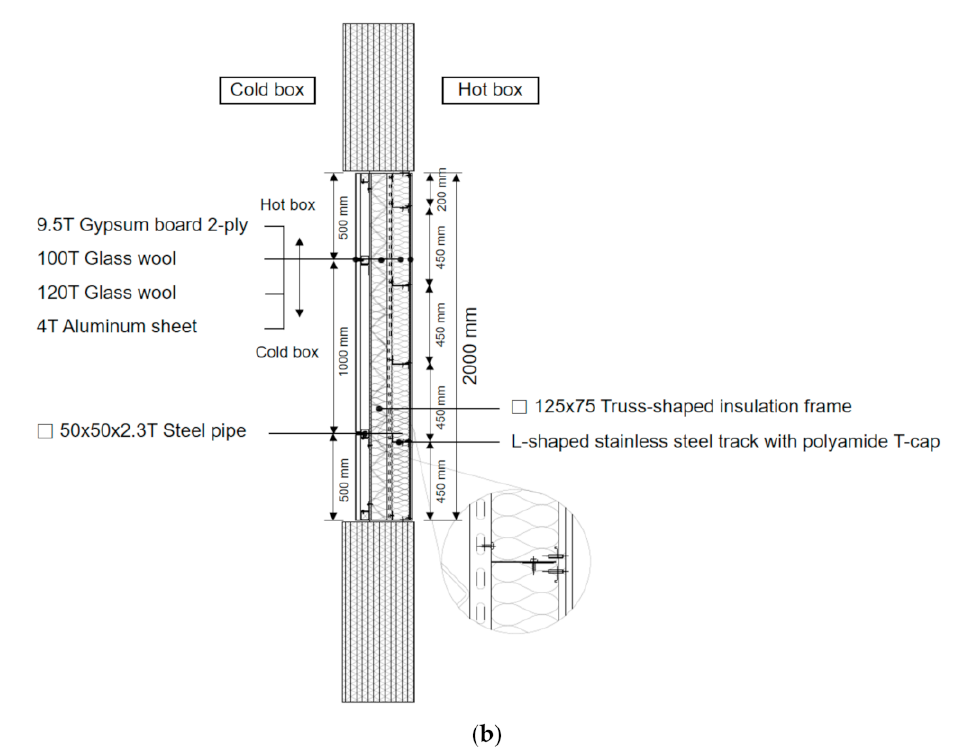
Figure 12. Vertical sections of mock-ups: ( a ) base case; ( b ) alternative case.